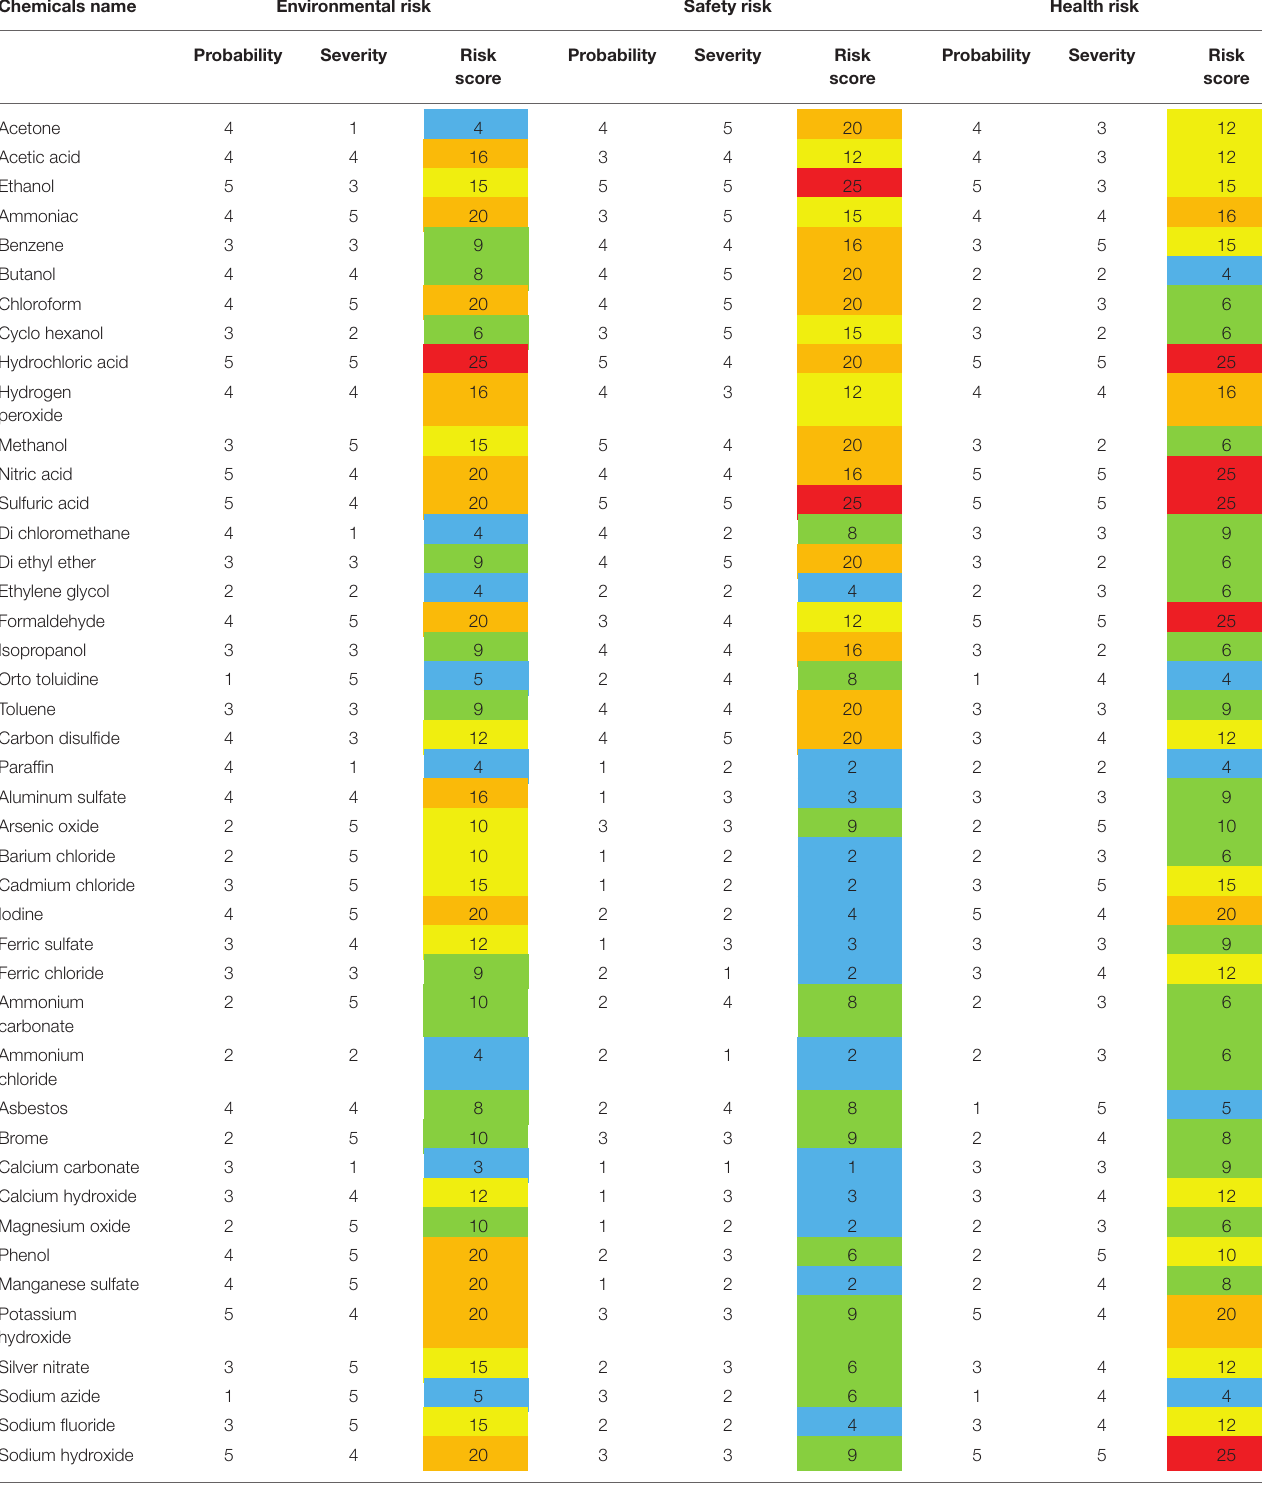
TABLE 3 | Health, safety, and environmental risk assessment matrix of common chemicals used in university